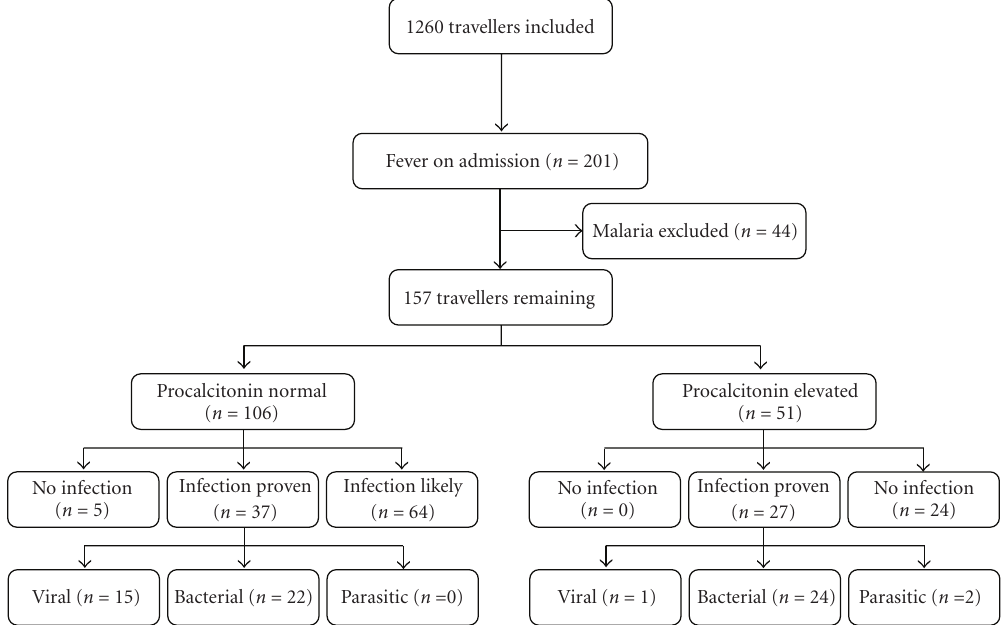
Figure 1: Flow-chart of procalcitonin test results on admission in relation to a predefined outcome in a cohort of 157 consecutive travellers who presented with fever (i.e., a body temperature ≥ 38.5 ◦ C on admission). An elevated procalcitonin level was defined as a PCT level ≥ 0 . 5ng/mL as measured with a semiquantitative